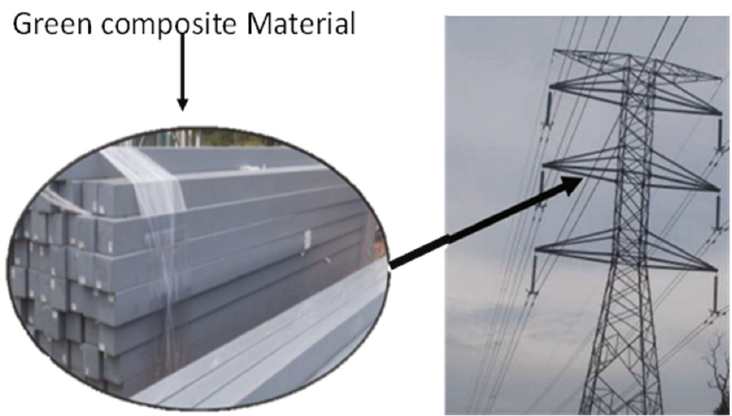
Figure 19. Potential application of green composite in cross ‐ arm beams [43].